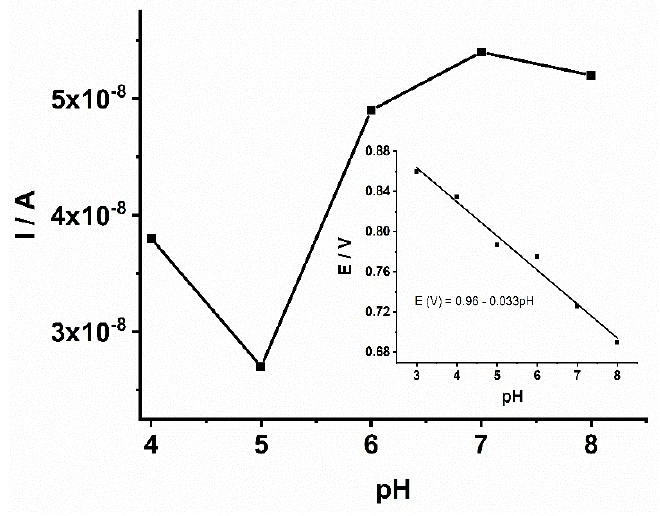
Figure 5. The influence of pH on the response of the SNGCE/AuNP electrochemical sensor in the presence of 10 µM melatonin. Inset: the dependence of the oxidation peak potential on pH.